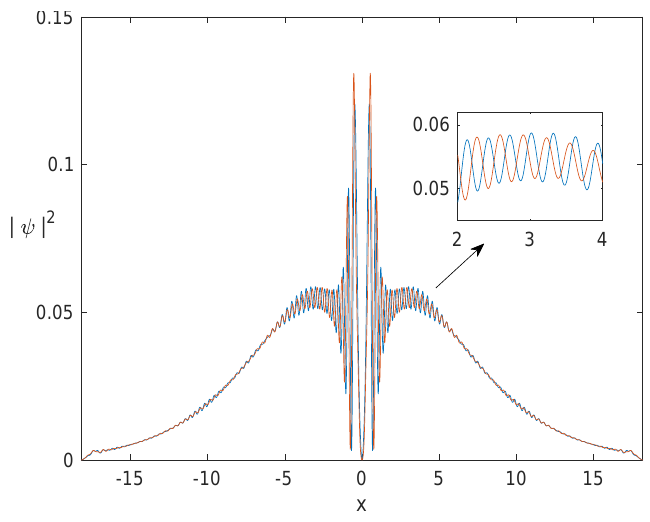
Figure 3: The two components of the wave-function for n = 20 decoupling steps. We plot the square modulus for the monopole picture on the whole real line. The inset shows the phase differences leading to an overlap of ≈ 0.95. The initial-wave ( x ) = ψ ( x ) ∝ xe −| x | / 5 function was chosen as ψ 0 1